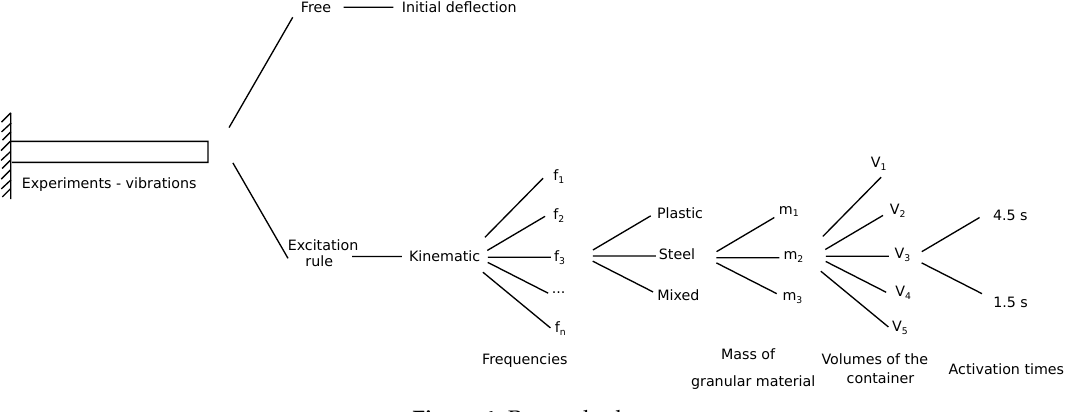
Experiments - vibrations